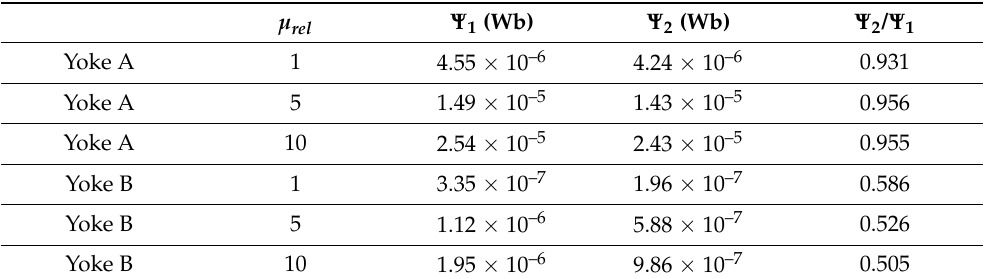
Table 3. Numerical result of simulation of the magnetic flux for the two different yokes and for three different values of relative permeability of the cladding. µ rel Ψ 1 (Wb)